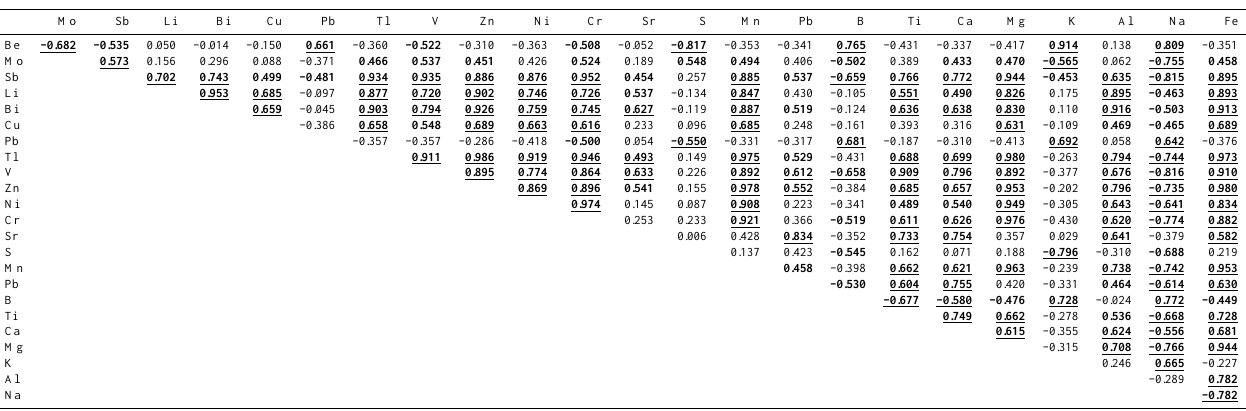
Table 4. Pearson correlation coefficients among elements (mgkg − 1 ) in the samples of all soil profiles. Bold face numbers are significant at the 95% confidence level, underlined numbers are significant at the 99% confidence